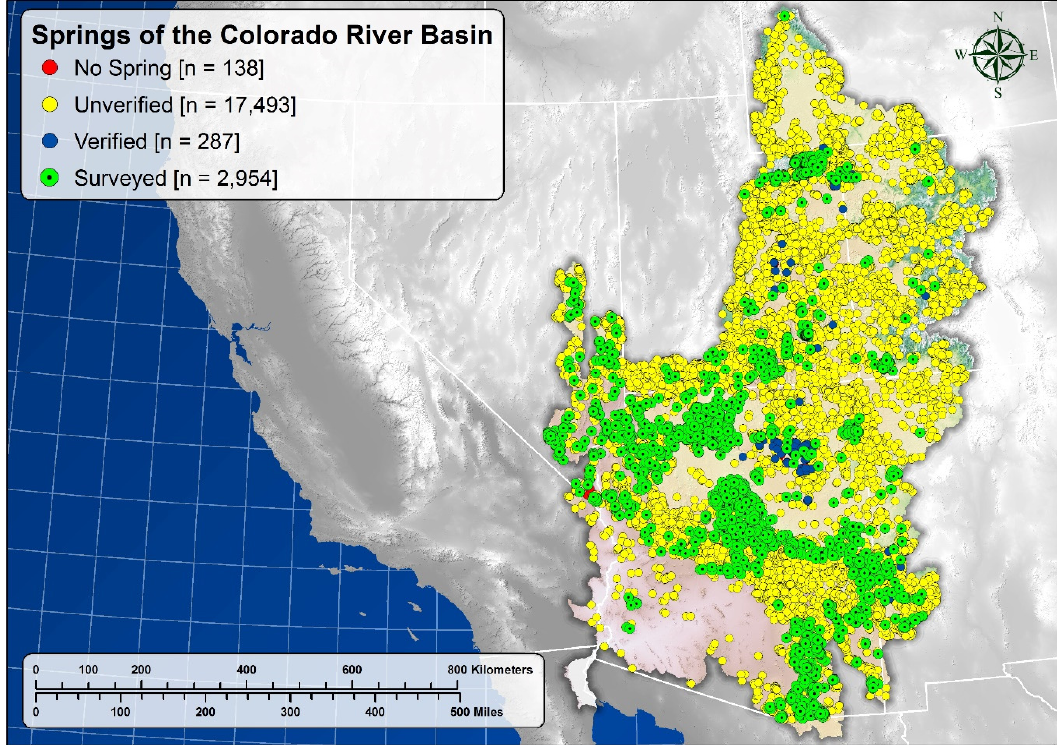
Figure 2. Map of the reported and inventoried springs of the Colorado River Basin. Surveyed springs are green; verified but not inventoried springs are dark blue; and unverified, un-inventoried springs are yellow. Springs mapped erroneously are red.